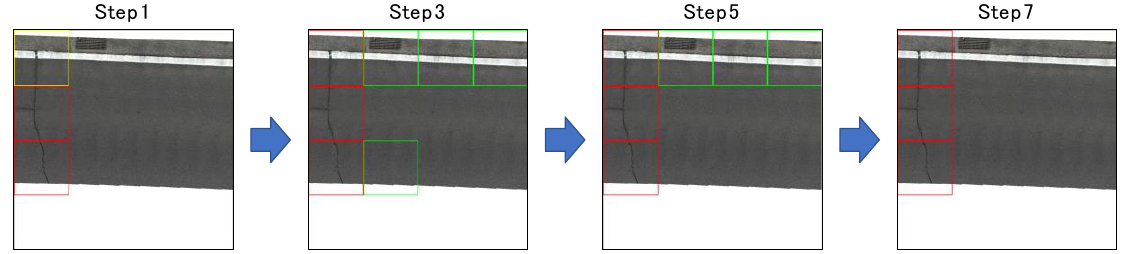
Figure 7. Improvement of the analysis results with an increase in the number of steps.